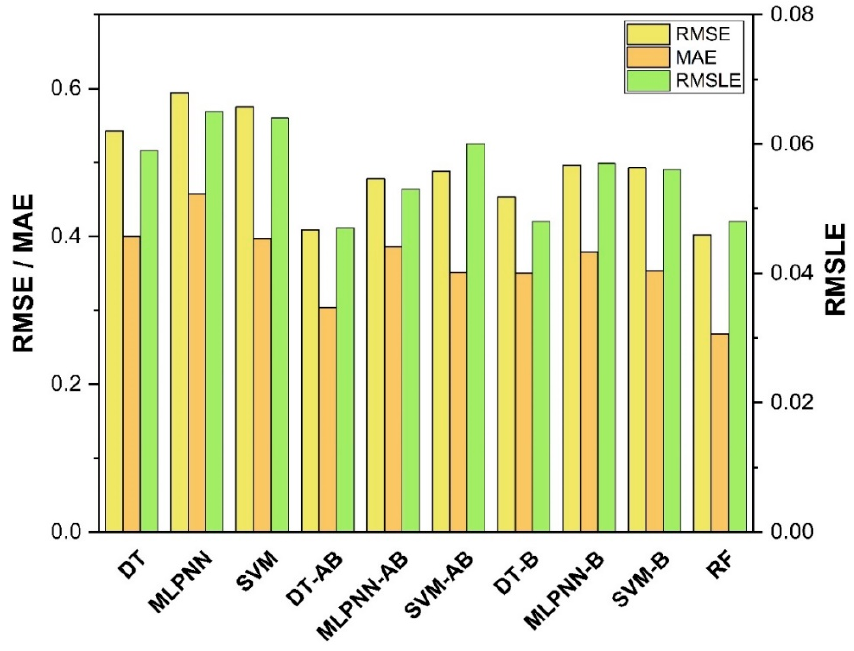
Figure 20. Statistical analysis of compressive strength models .